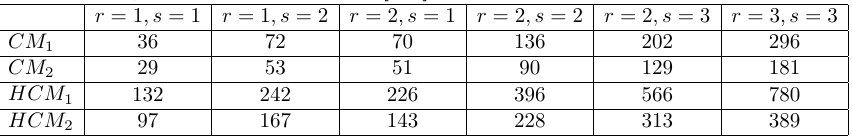
Table 1. first and second reverse Zagreb and first and second reverse hyper Zagreb indices for Si 2 C 3 I [ r, s ] for specific values of r and